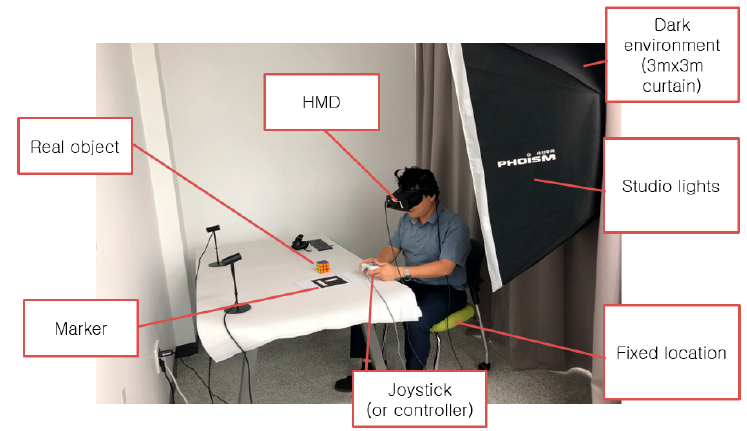
Figure 6. System set-up in our experiment. The participant wearing the HMD sat in a chair and compared the size of the actual cube with that of the virtual one. The participant could adjust the size of the virtual cube using a joystick (or controller). The participant used the same controller to interact with the virtual